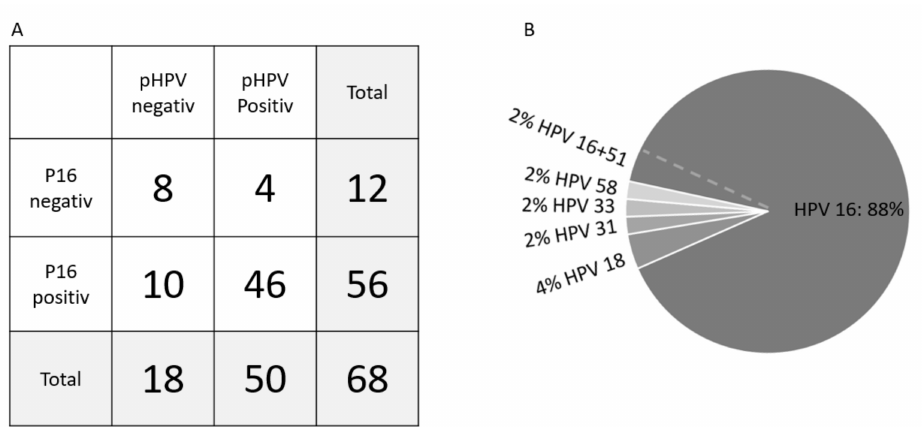
Figure 1. Concordance between tumor P16- and pHPV status ( A ) and pHPV subtype distribution ( B ). ( A ) Concordance between P16 immunohistochemically staining and pHPV status showed a concordance of 79% and a pHPV sensitivity of 82% and specificity of 67%. ( B ) The distribution of HPV subtypes with 90% HPV16 and 4% HPV18. The rare subtypes (31, 33, and 58) contributed with 2% each. One sample was positive for both subtype 16 and